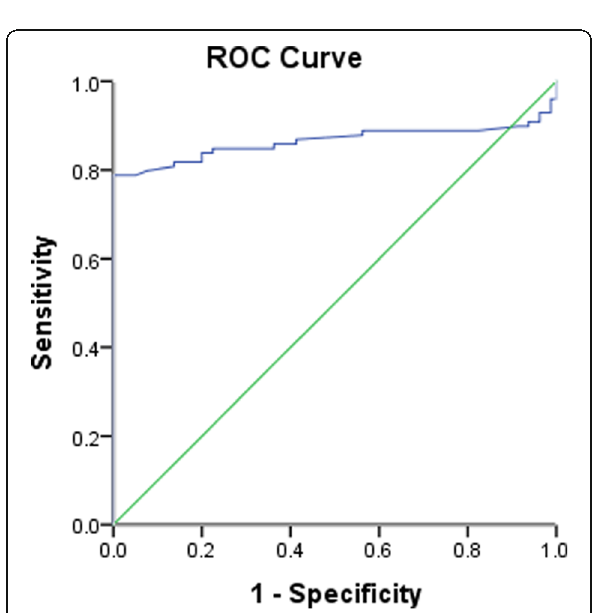
Fig. 3 ROC curve analysis for AFP showing the best cutoff value to differentiate between the HCC and normal control groups. Area under the curve (AUC) was 0.864